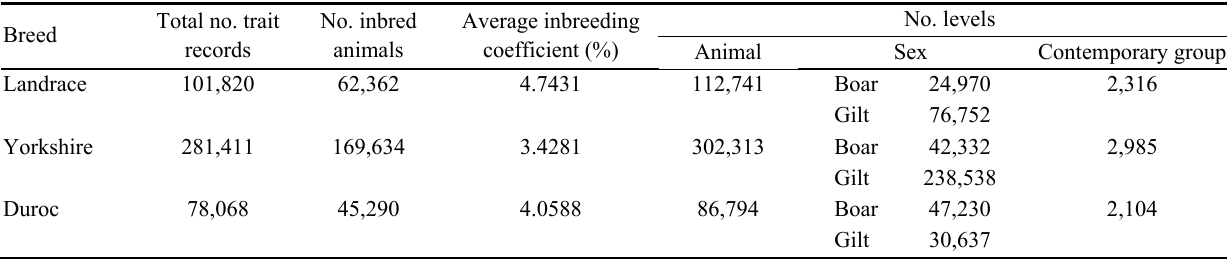
Table 2. Pedigree and performance data structure by breeds Total no. Breed